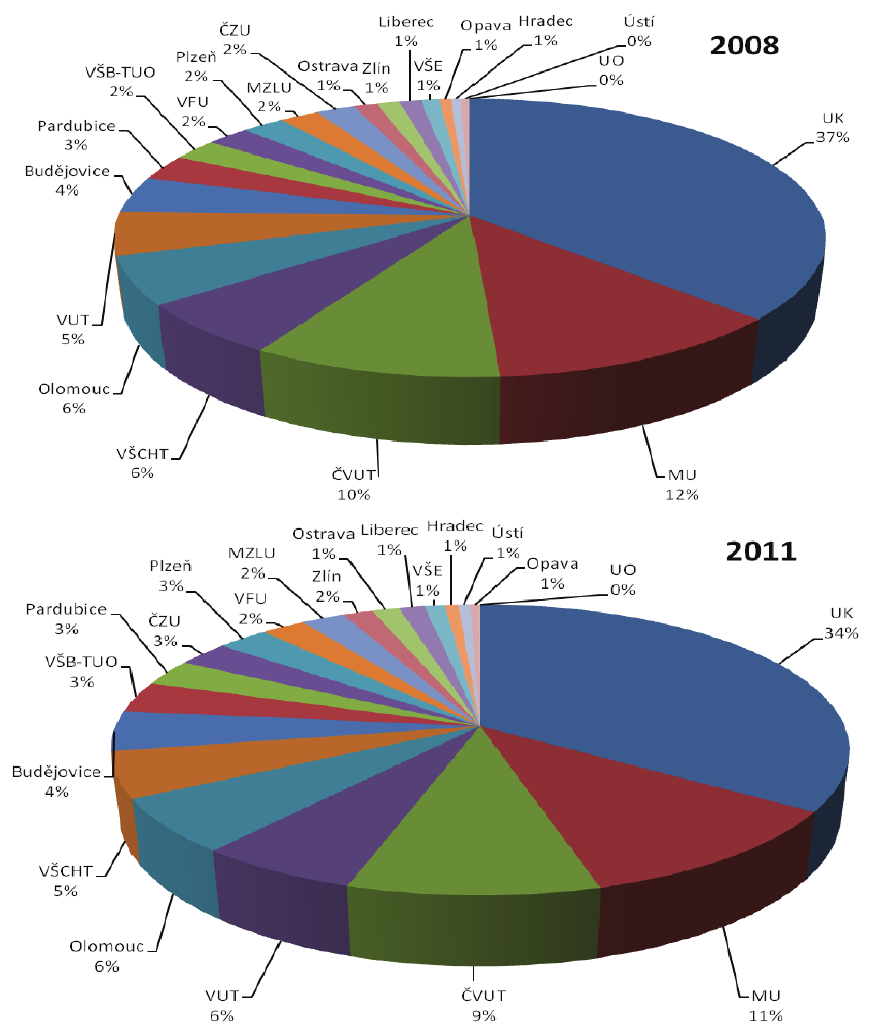
Figure 2. Relative university publication output in 2008 and 2011 by Web of Science